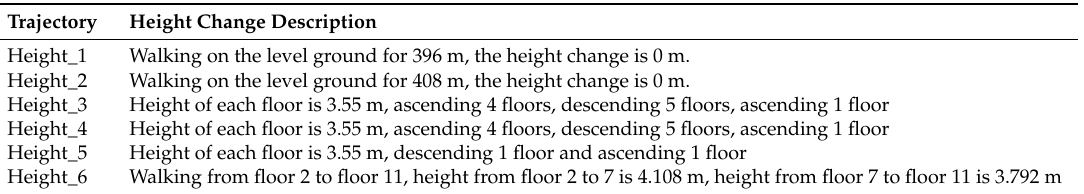
Table 6. Description of the test trajectories.